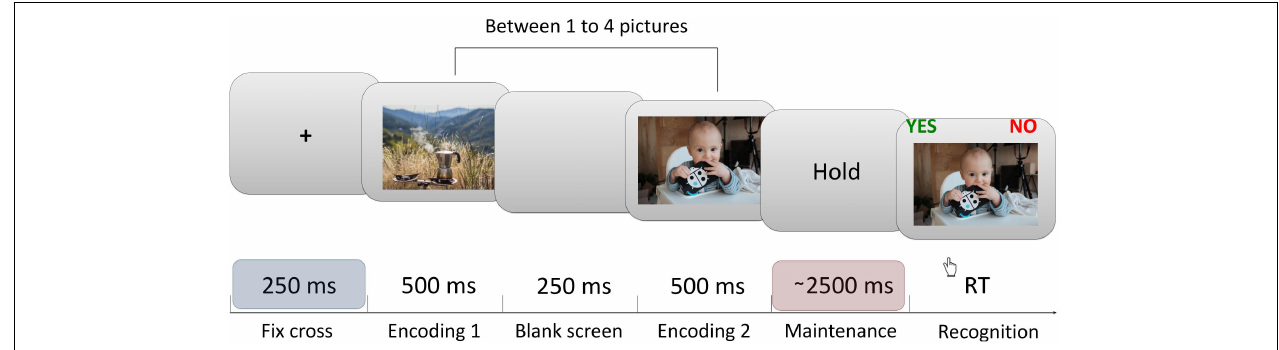
FIGURE 1 | Sternberg task’s trial structure. Each trial began with a central fixation cross presented for 250 ms, followed by a sequential presentation of between one to four pictures (encoding phase). This was followed by the maintenance (delay) period lasting between 2,500 to 2,800 ms (randomly). Finally, after the delay, a probe image was shown. Participants were instructed to respond whether the probe was or was not presented during the encoding period that immediately preceded the probe. All EEG data analysis shown in this article were computed from the last ∼ 1.5 s (1,000–2,450 ms) interval of the maintenance period in order to avoid the activity evoked by the last image presentation. Each participant completed 120 trials of the